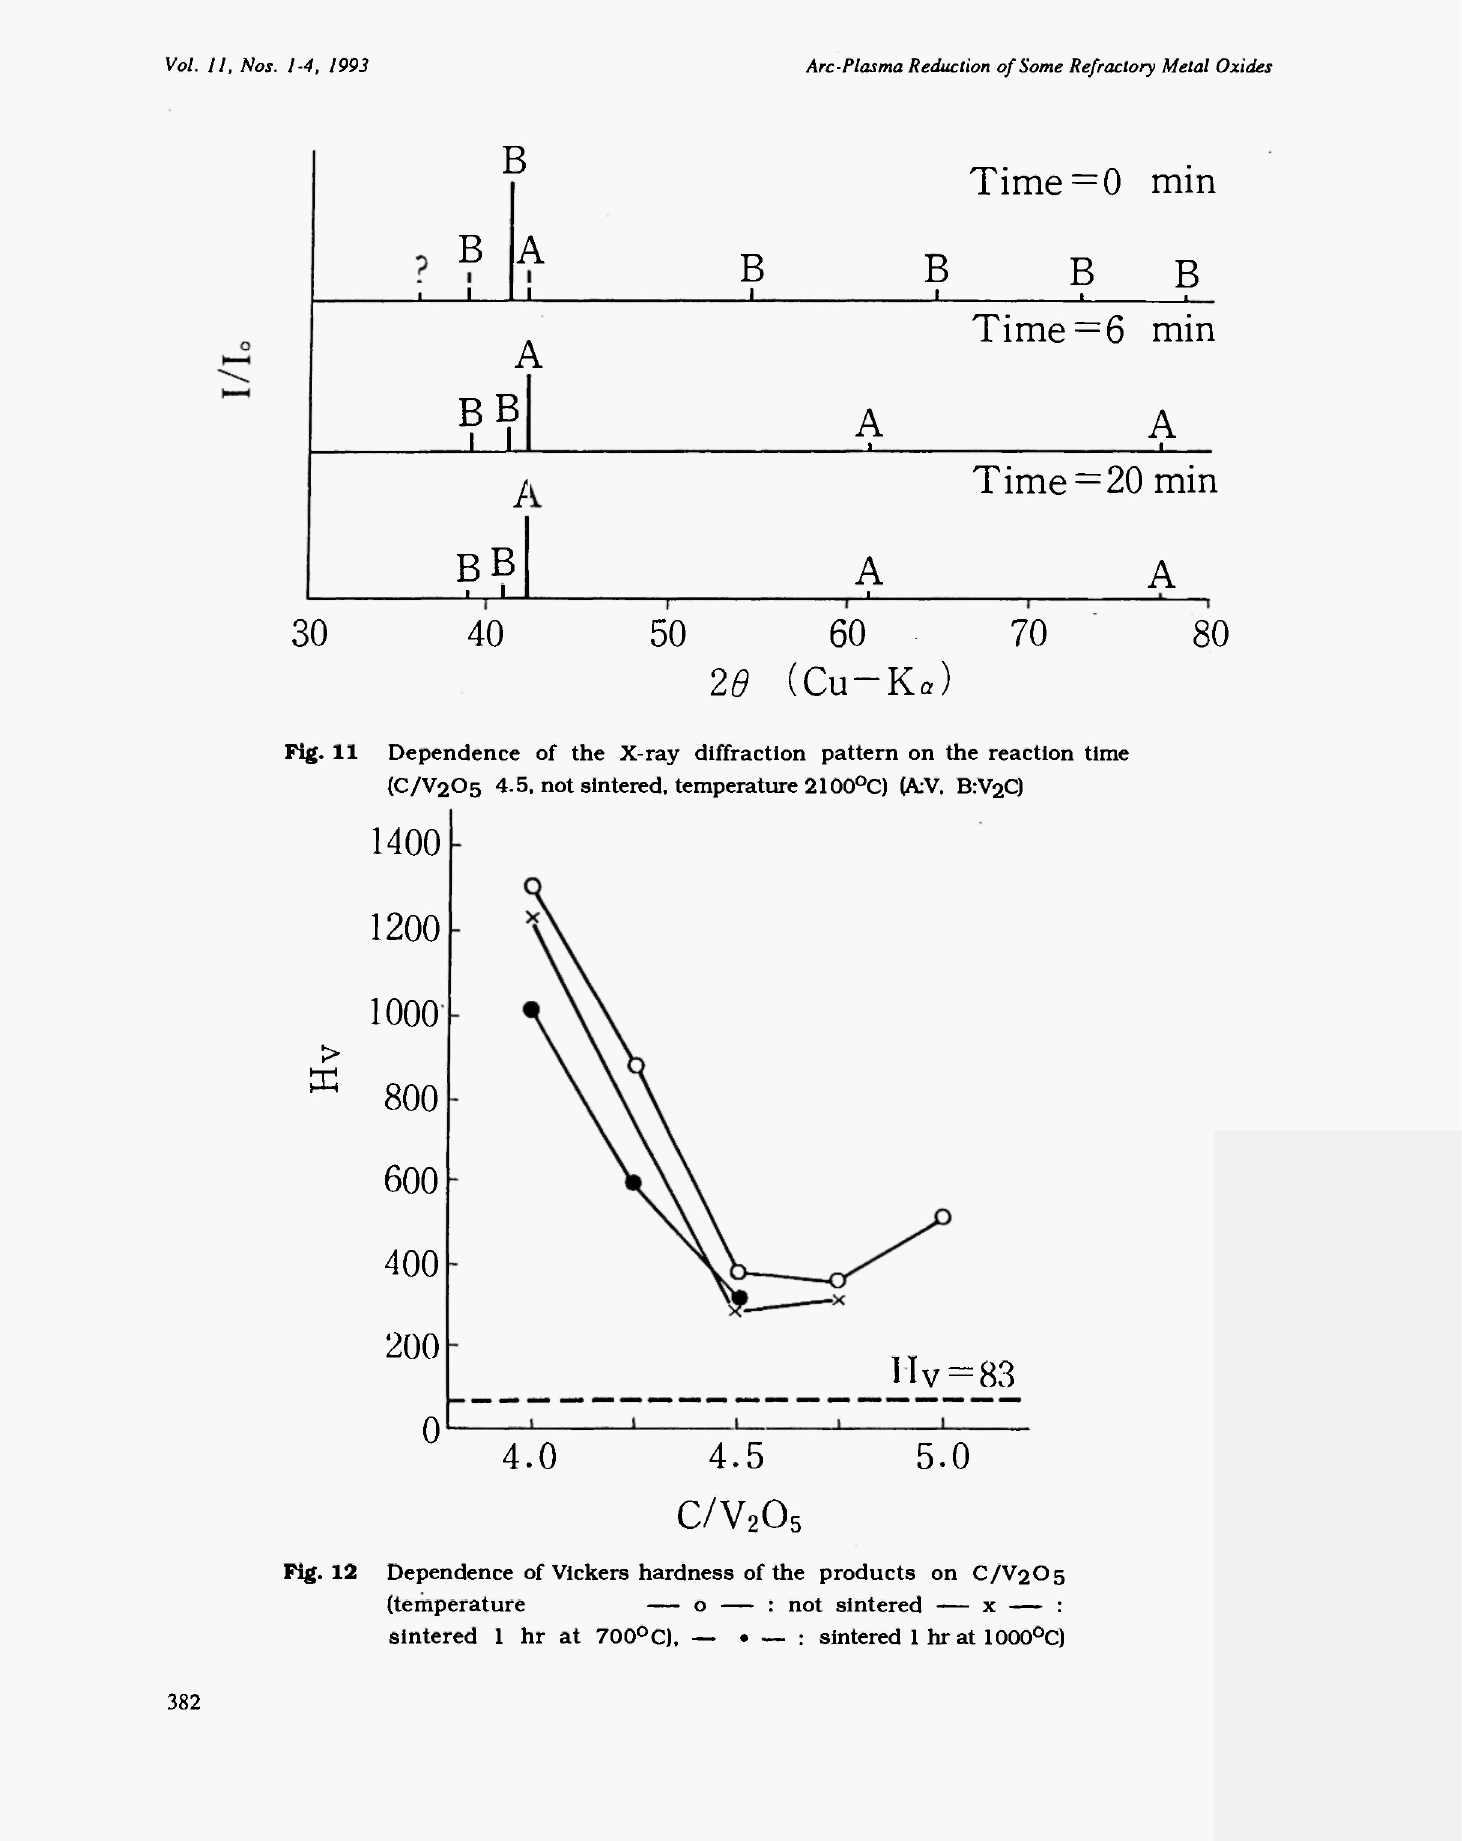
Fig. 12 Dependence of Vickers hardness of the products on C/V2O5 (temperature ο : not sintered -— χ : sintered 1 hr at 700°C),